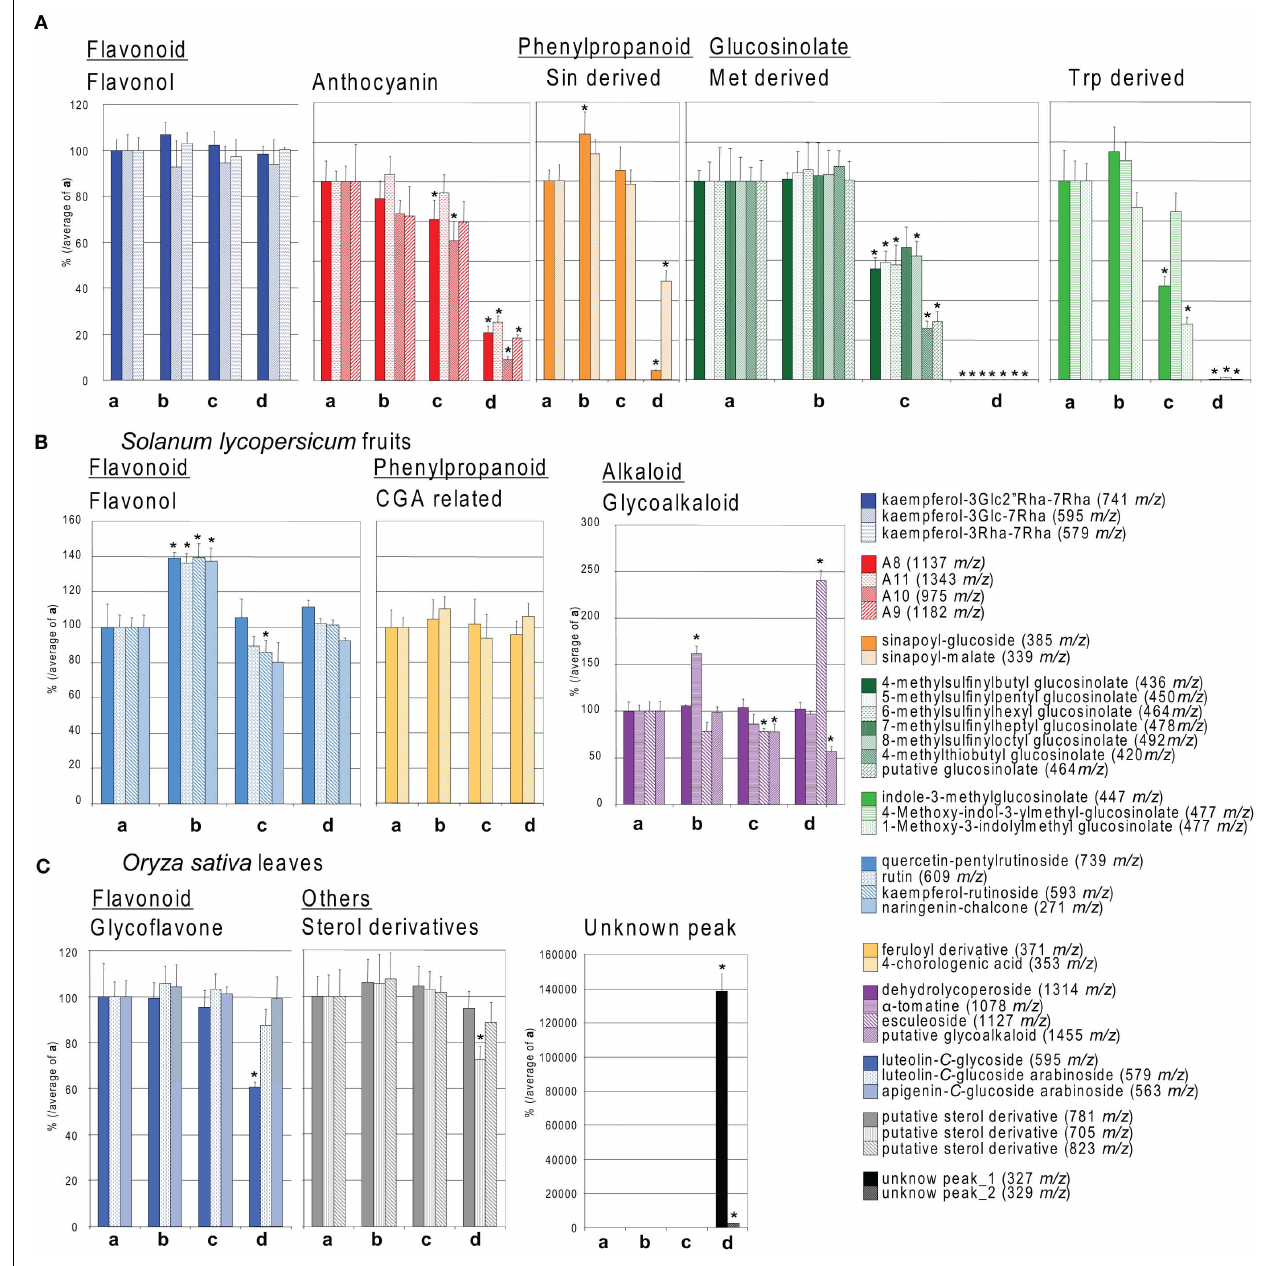
phenylpropanoid related compounds (sinapoyl-derivatives and chlorogenate-related compound); green, glucosinolate related compounds in Arabidopsis (methionine-derived aliphatic glucosinolate and tryptophan-related aromatic glucosinolate); purple, indicates glycoalkaloid; gray, putative sterol derivative; black, unknown compounds.The m/z value detected in negative ion detection is indicated between parentheses. Average of three experimental replicates ± SD. Significant differences by t -test ( p < 0.05) are marked by asterisks.